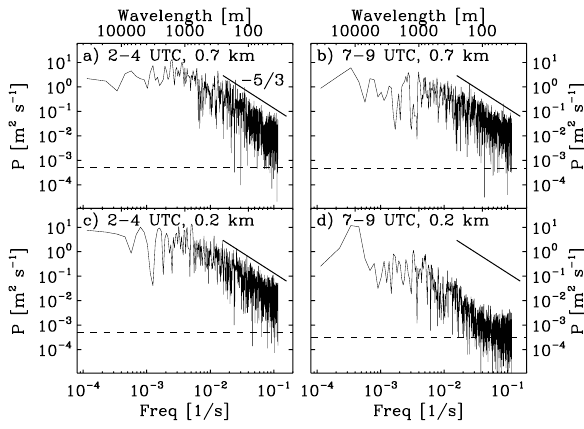
Fig. 2. Power spectra computed from 10 11 samples ( ∼ 2h) of mean Doppler velocity measurements at two times and two heights during the 28 August 2008 case at ASCOS shown in Fig. 1. For reference, each panel includes a solid line of − 5/3 slope and a dashed line showing the noise contribution to the velocity variance computed using Eq. (4). Wavelength axes are estimated using the observed horizontal wind speed ( ∼ 4ms − 1 )